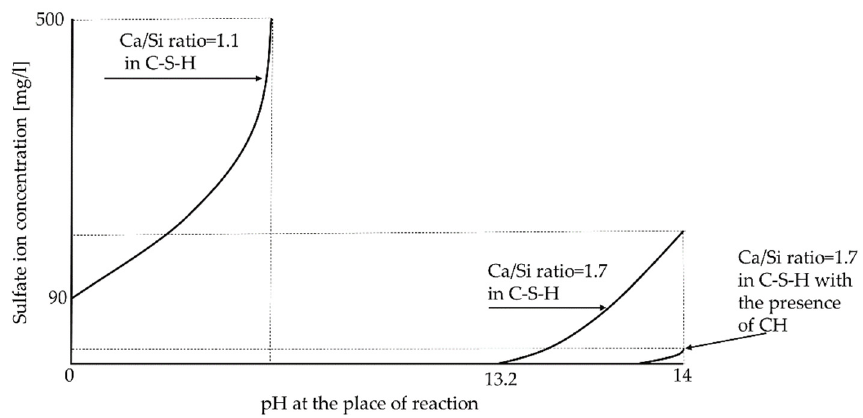
Figure 11. Minimum sulphate ion concentrations required for the transformation of C-S-H phases into thaumasite as obtained by thermodynamic calculation [222].